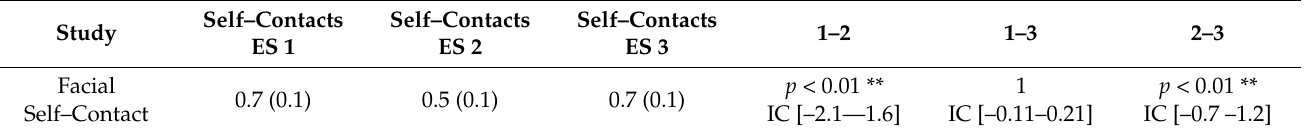
Table 4. ANOVA measurement repeated for the self–contact variable in the different experimental situations.